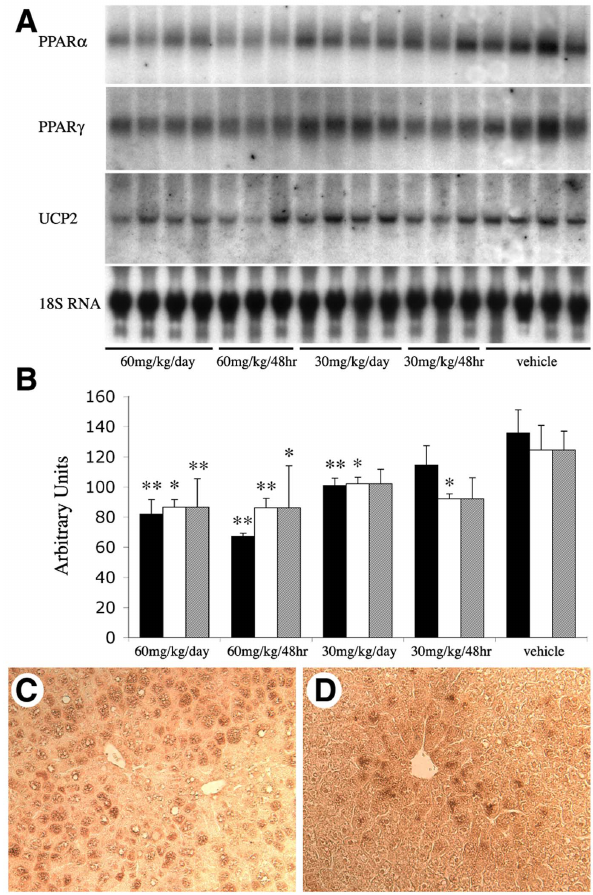
Figure 5. Expression of UCP2 and PPAR a and c . A. Northern blot analysis of PPAR a , PPAR c , and UCP2 . ob/ob mouse livers received 7-day (every day or every other day) treatment of cerulenin or vehicle as indicated. 18 S RNA was used for normalization. B. The densitometric values are expressed as averages standardized to baseline. C ( vehicle- treated) and D (60 mg/kg/day for 7 days) are PPAR c immunostaining signals in ob/ob mouse livers, Scale bar: 60 m m.